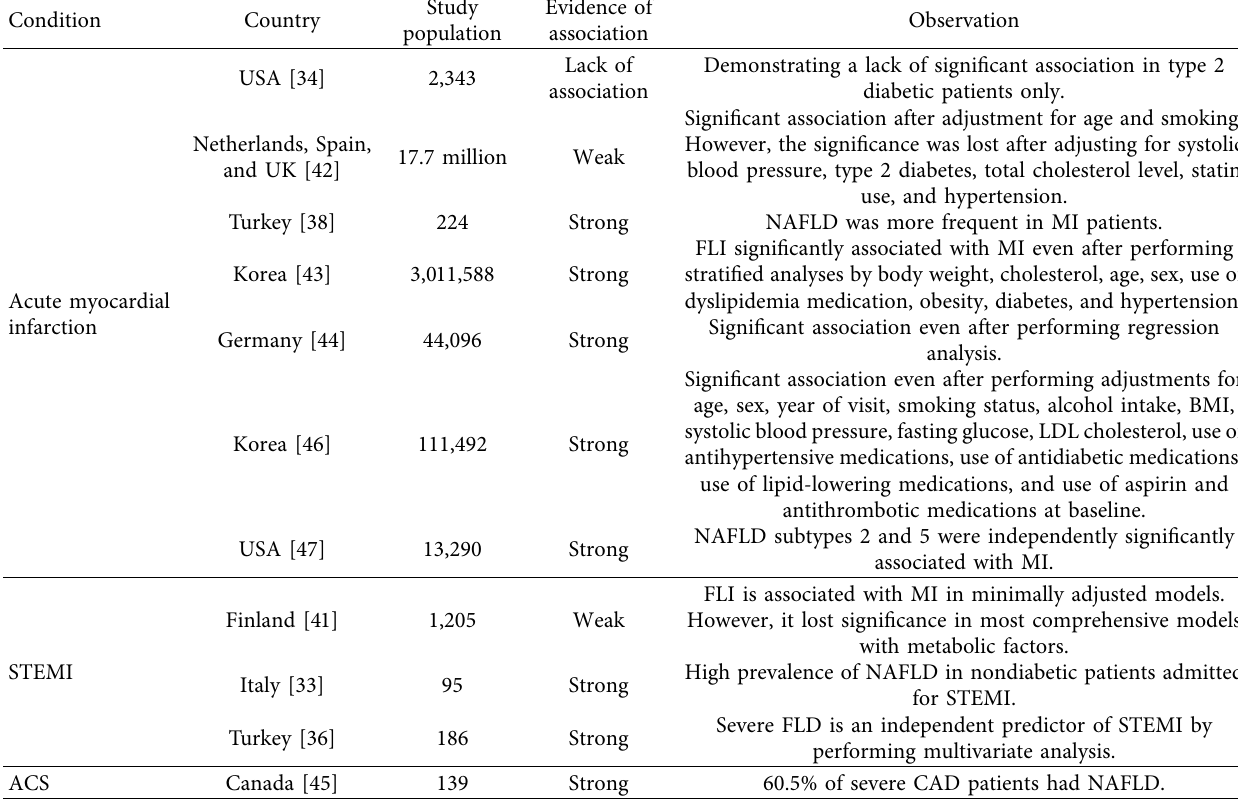
Table 3: Evidence evaluating the association between ACS and